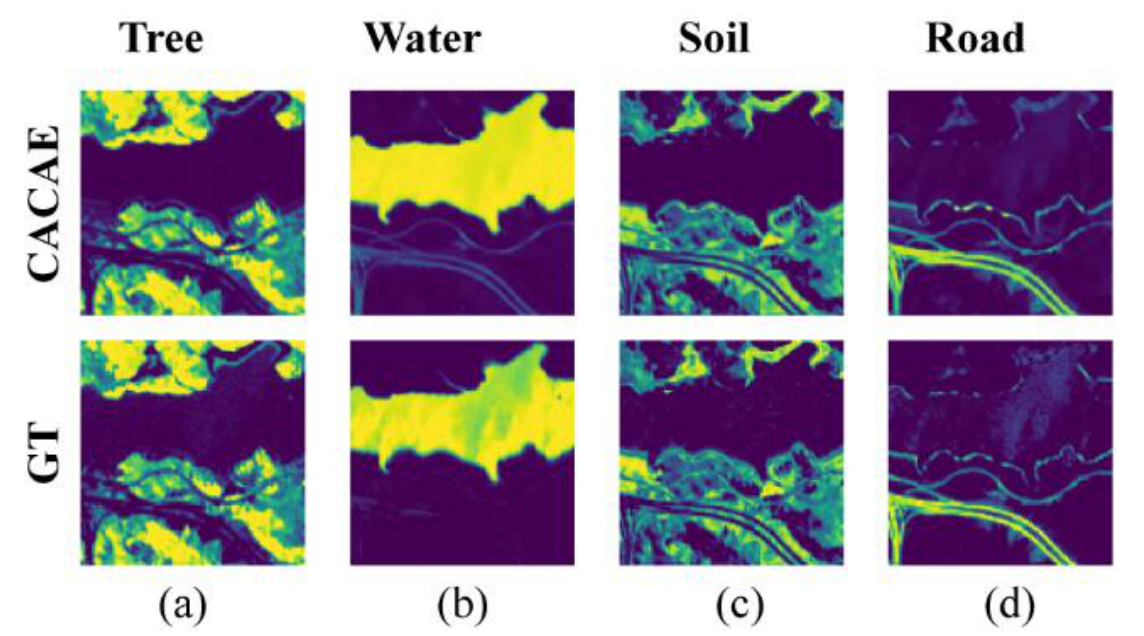
Figure 6. Abundance maps estimated by CACAE and the true abundance maps from the Jasper Ridge dataset. ( a ) Tree; ( b ) Water; ( c ) Soil; ( d ) Road.